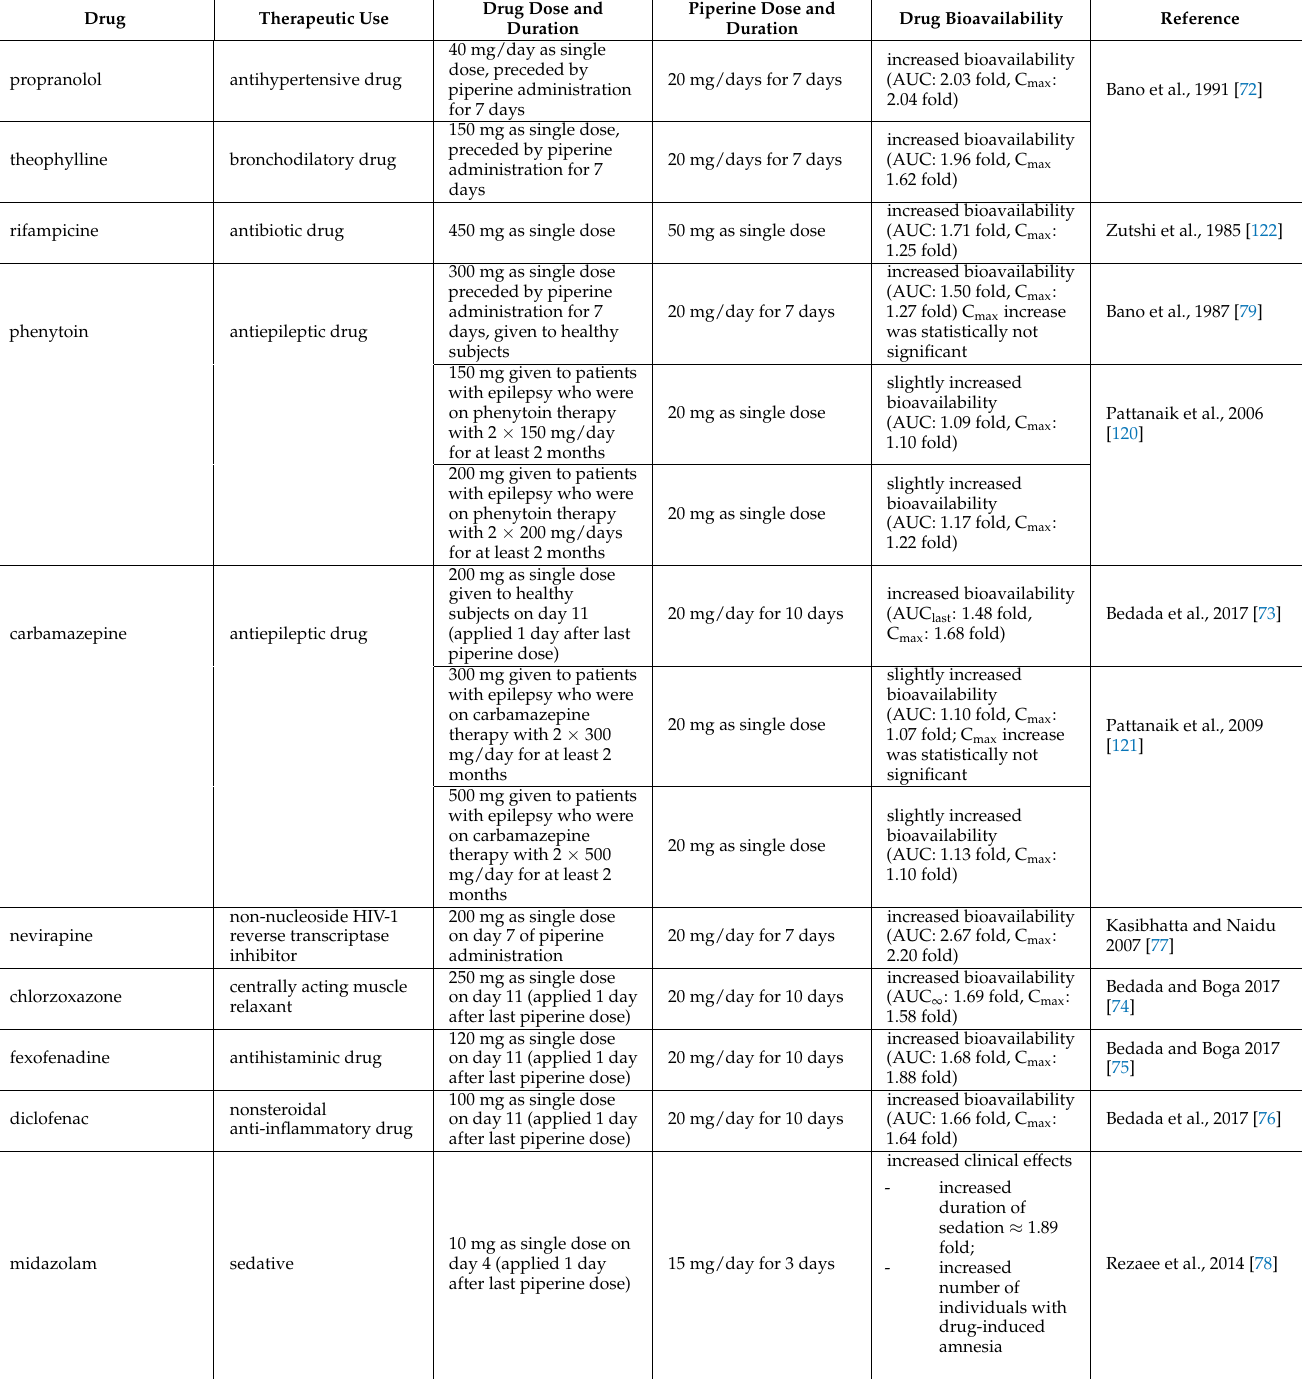
Table 2. Effects of piperine on the bioavailability of drugs in human